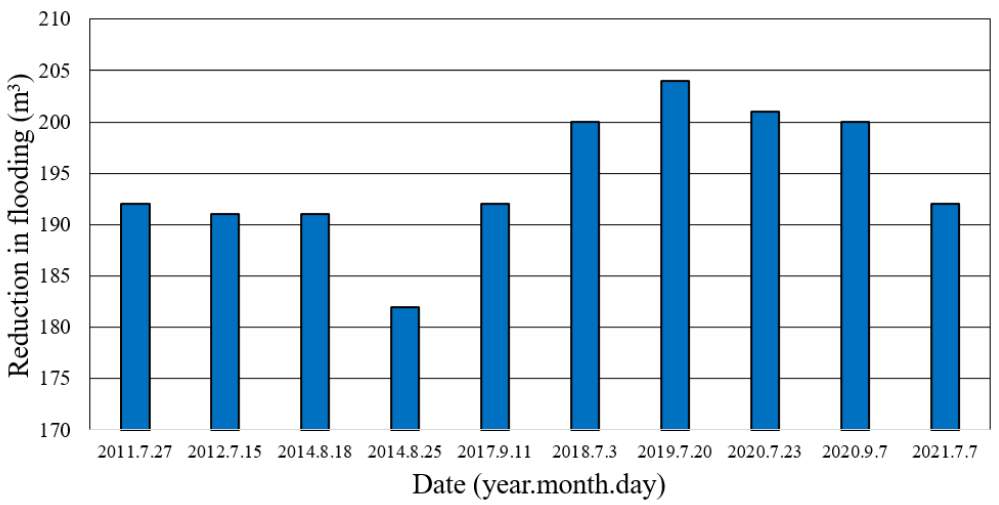
Figure 14. Flood reduction at Location 2 after structural problem resolution.